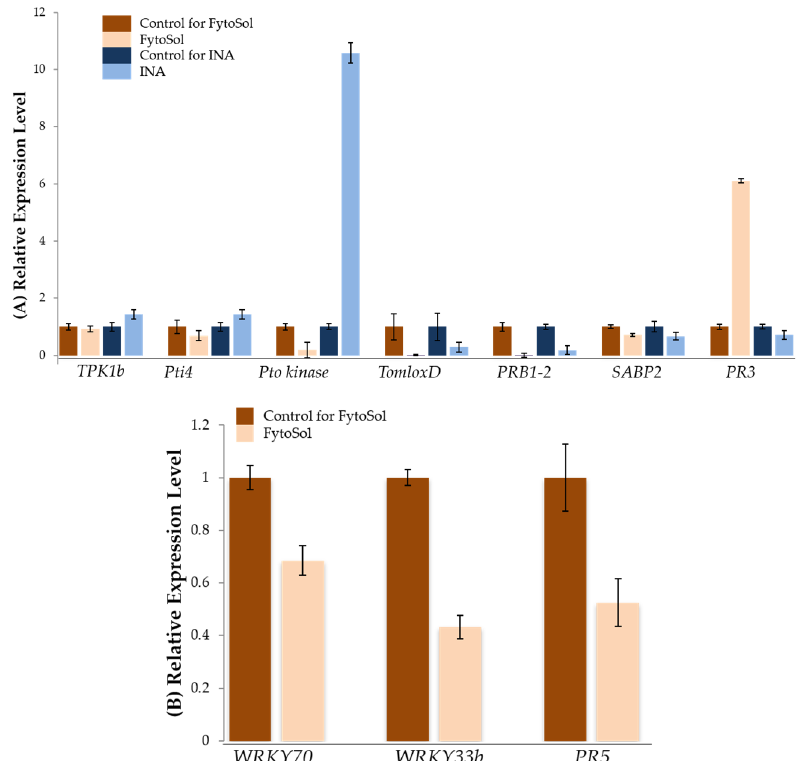
Figure 4. Effects of FytoSol and 2,6-dichloroisonicotinic acid (INA) on transcriptional changes of defense-related genes in the tomato. ( A ) Quantitative real-time PCR analysis of defense-related genes; TPK1b , Pti4 , Pto kinase , TomloxD , PRB1-2 , SABP2 , PR3 after FytoSol, INA, or control applications. ( B ) Quantitative real-time PCR analysis of defense-related genes; WRKY33b , WRKY70 , PR-5 after FytoSol or control applications. Values present mean ± SE of three biological replicates per treatment. Defense-related genes were normalized to Actin .